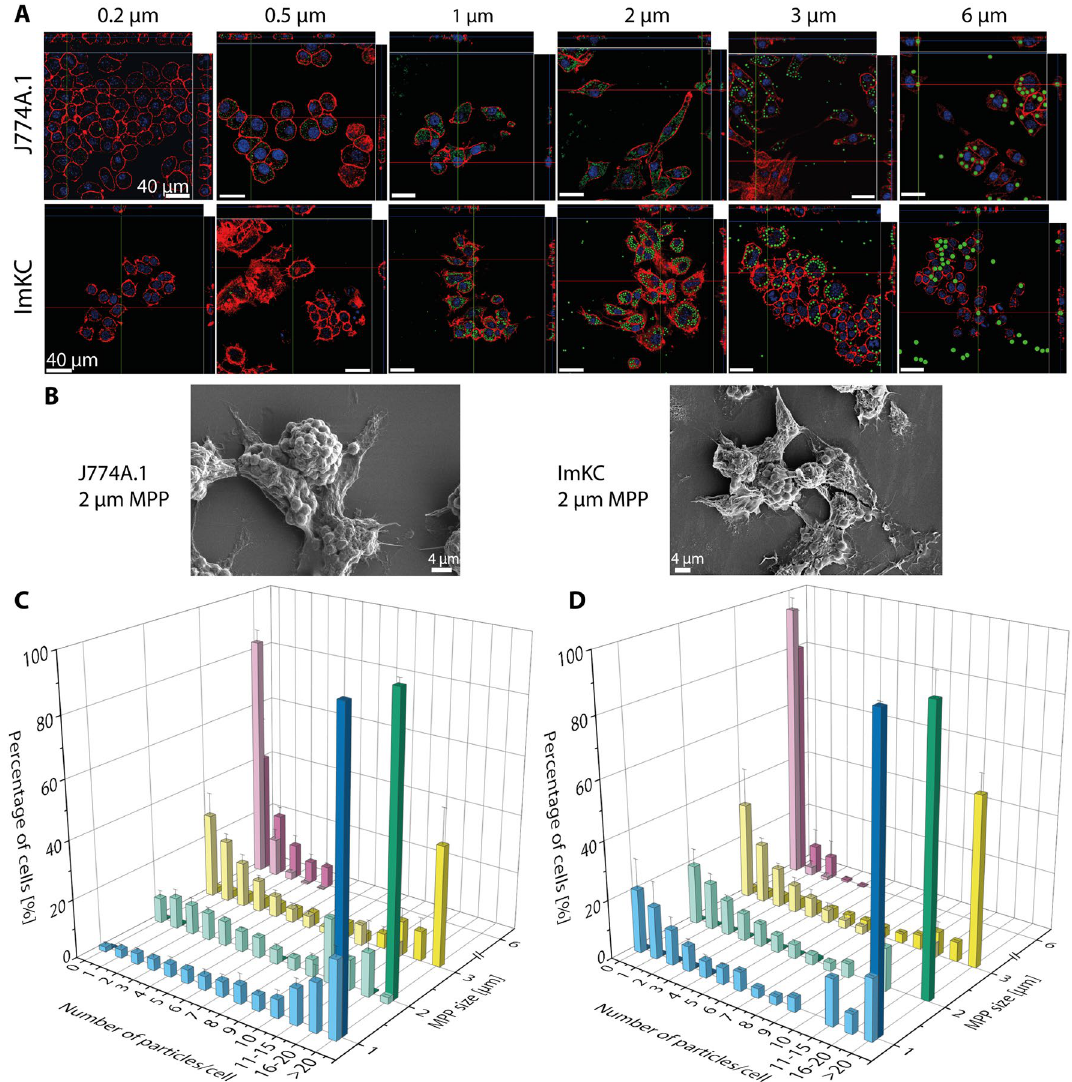
Figure 1. Analysis of size-dependent uptake of PS-MPP by J774A.1 and ImKC macrophages. Analysis was performed using confocal laser scanning microscopy (CLSM, A ), scanning electron microscopy (SEM, B ), and flow cytometry ( C , D ). ( A ) Size and number of added particles per cell: 0.2 µm: 750,000, 0.5 µm: 48,000, 1 µm: 2000, 2 µm: 700, 3 µm: 200, 6 µm: 25. Actin filaments were stained with rhodamine-phalloidin (red), nuclei were stained with DAPI (blue); FITC-fluorescent MPP are shown in green. Scale bars: 40 µm. ( B ) Representative SEM images are shown for each cell line in the presence of 2 µm MPP. Additional images are shown in Supplementary Fig. S2. Scale bars: 4 µm. ( C , D ) Results of flow cytometry measurements of J774A.1 ( C ) and ImKC ( D ). Shown are the percentage of cells in correspondence to the number of interacting particles per cell and the size of the particles. Light colors represent low concentration, dark colors the high concentration of MPP (see Table 2). Note that no data was available for 0.2 and 0.5 µm particles due to lacking resolution of the flow cytometer. The calculation of the number of interacting particles per cell is based on the fluorescence intensity of the particles (histograms, Supplementary Fig. S1). Data represent mean ± SD, n =